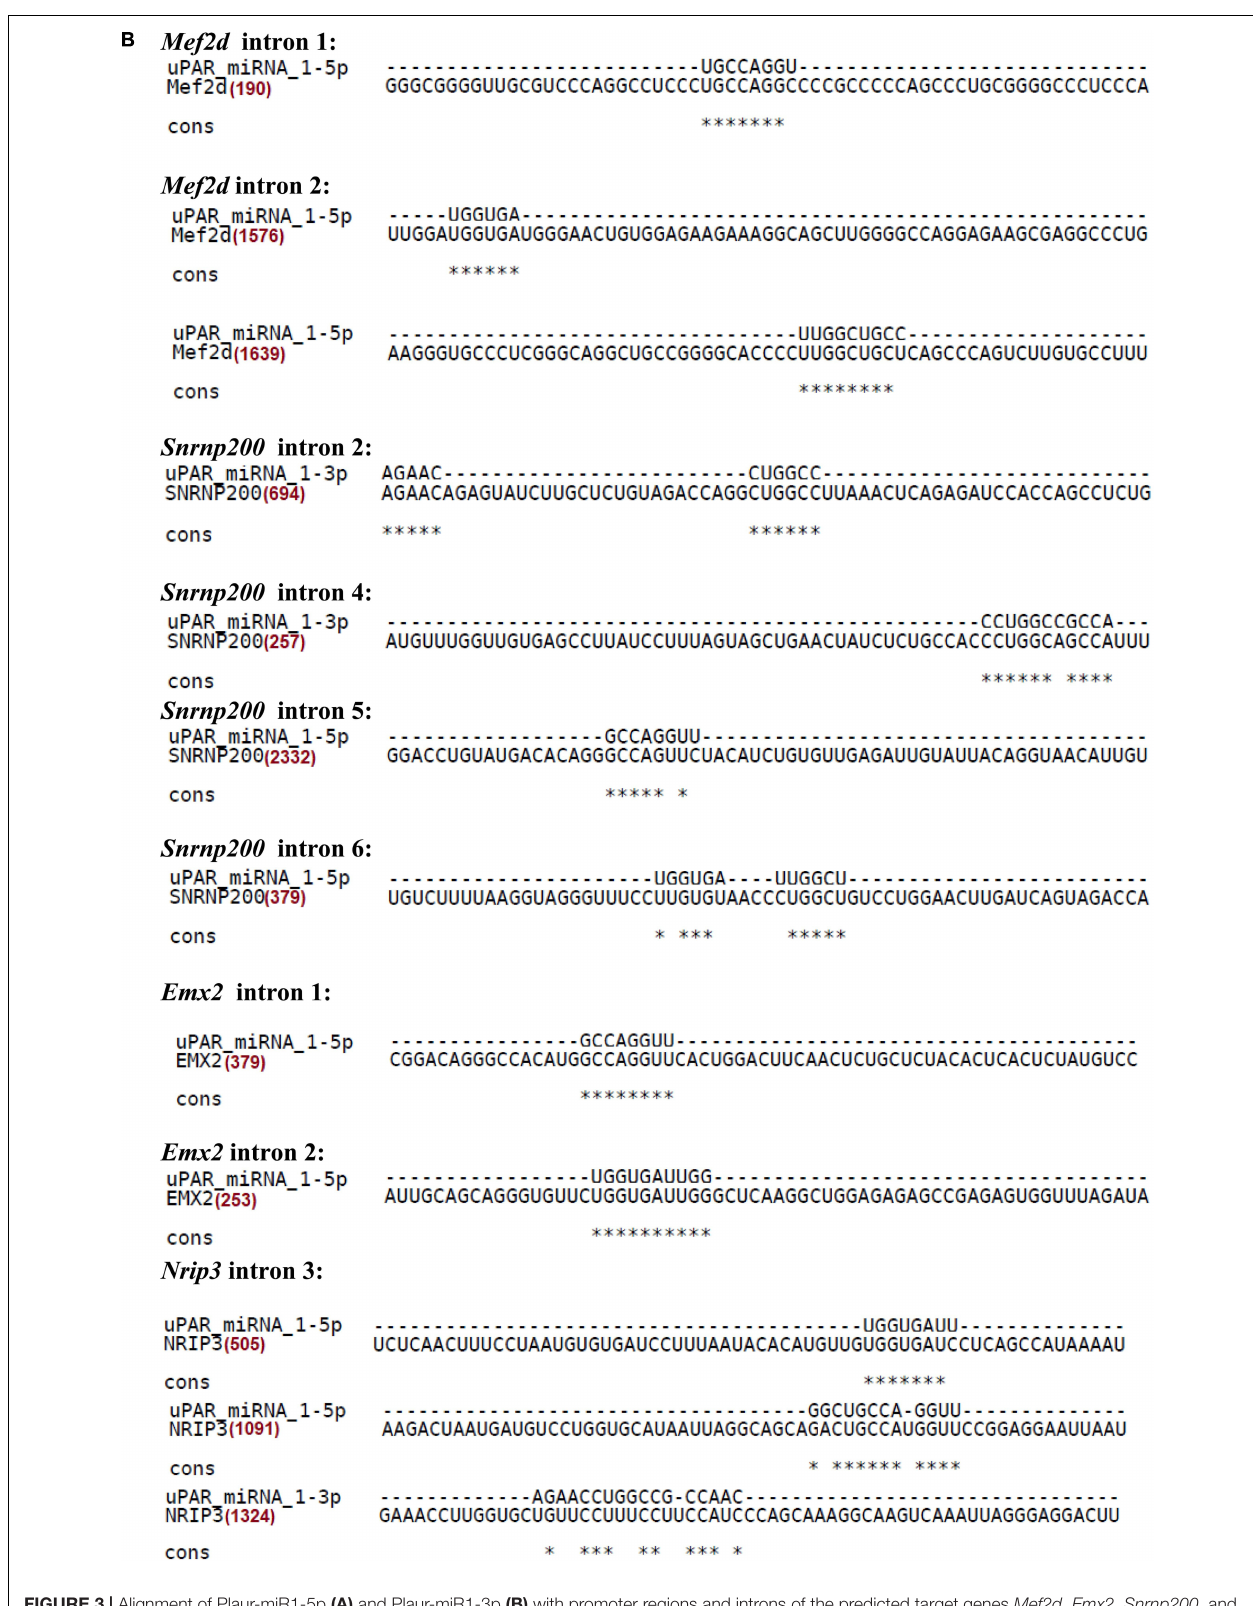
Frontiers in Molecular Neuroscience |